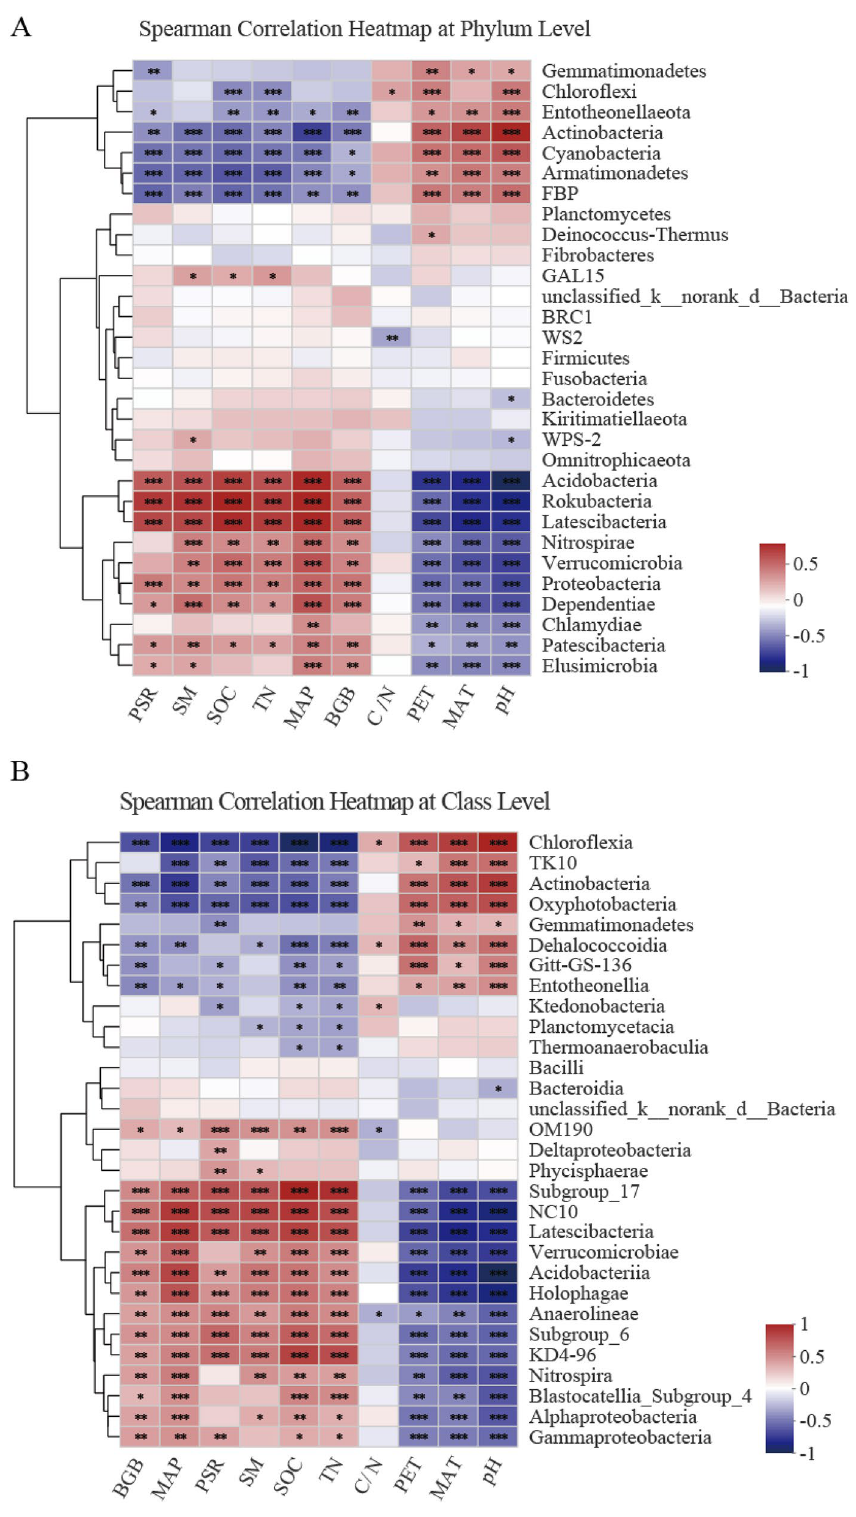
Figure 5. Spearman correlation analyses of the relationships between environmental variables and the top 30 bacterial phyla ( A ) or classes ( B ). Red and blue respectively denote positive and negative correlations. * P < 0.05, ** P < 0.01, *** P < 0.001. These were done in R with the pheatmap package (v3.3.1, http:// www.R- proje ct.